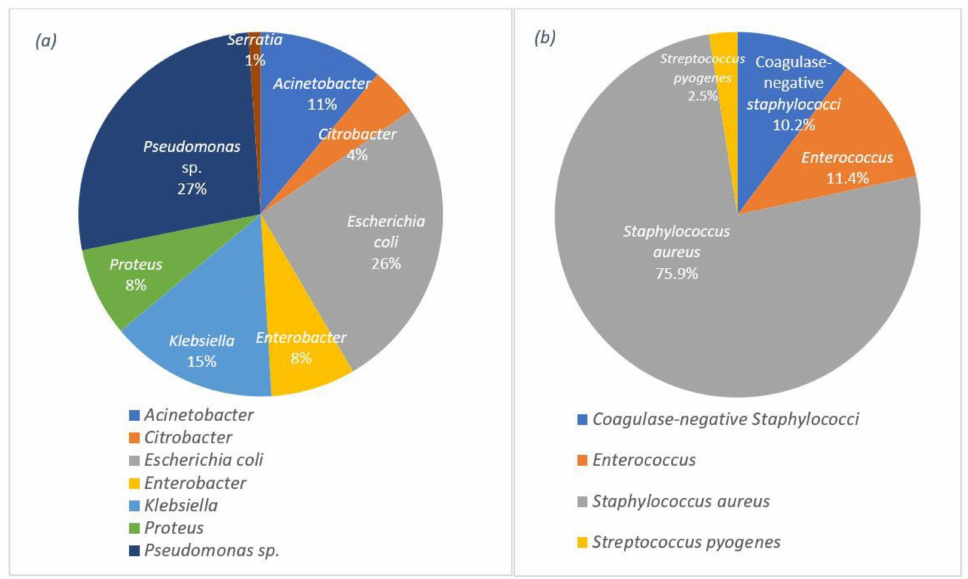
Figure 1. Distribution of the wound infections by: ( a ) the Gram-negative bacteria and ( b ) the Gram-positive